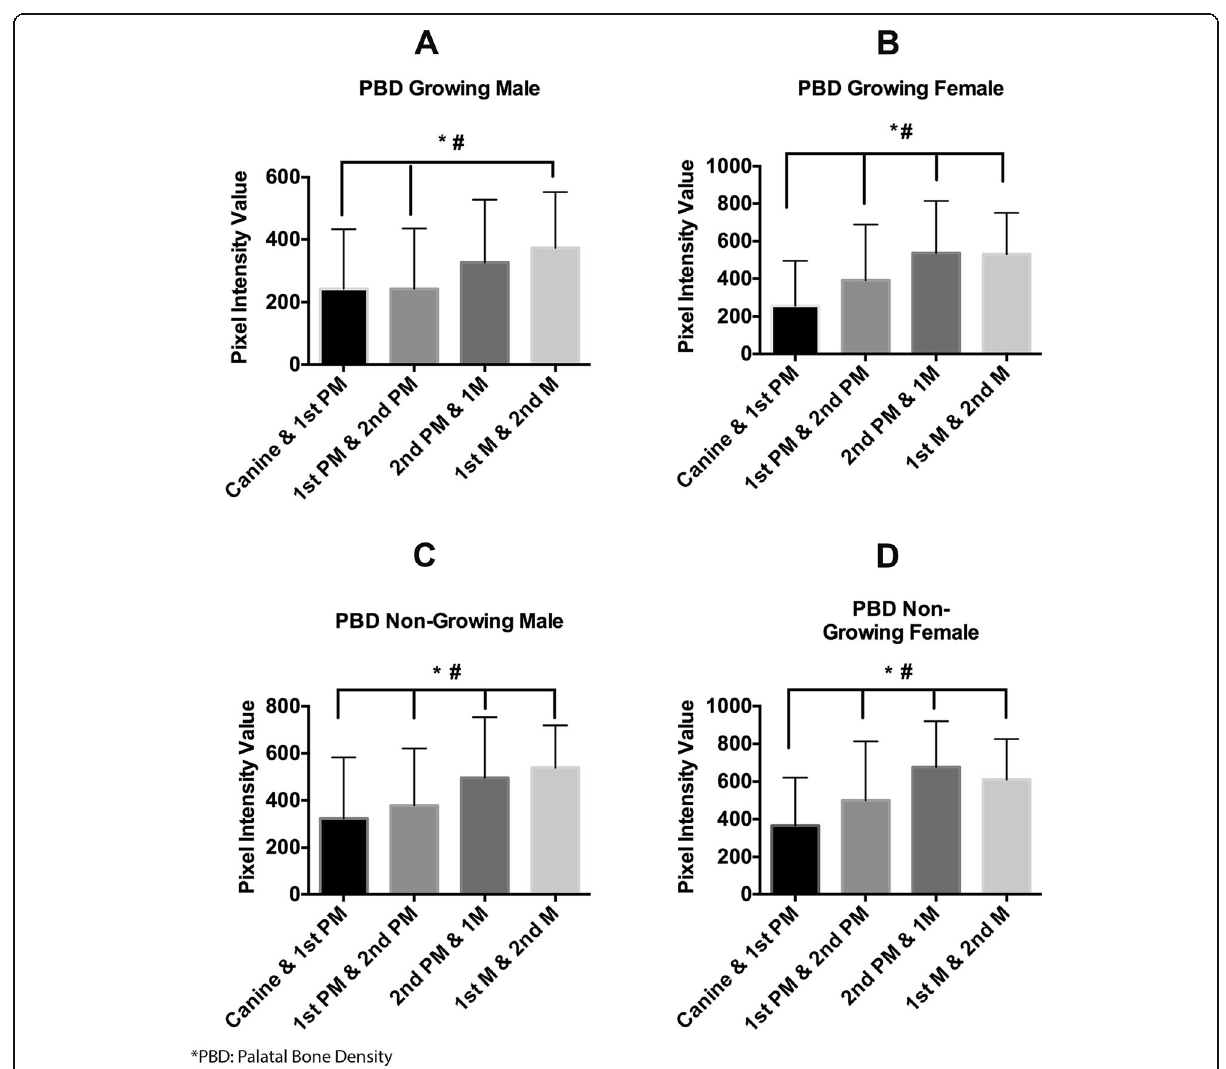
Fig. 4 Bar graph showing the palatal bone density among different groups at 4 mm from the center of palate. a Palatal bone density in growing male at four different points measured. b Palatal bone density in growing female at four different points measured. c Palatal bone density in non- growing male at four different points measured. d Palatal bone density in non-growing female at four different points measured. Asterisk depicts that palatal bone density is significantly more in between the second premolar and first when compared to other canine and first premolar and between first premolar and second premolar. Number sign depicts that palatal bone density is significantly more in between the first molar and second molar and first when compared to other canine and first premolar and between first premolar and second